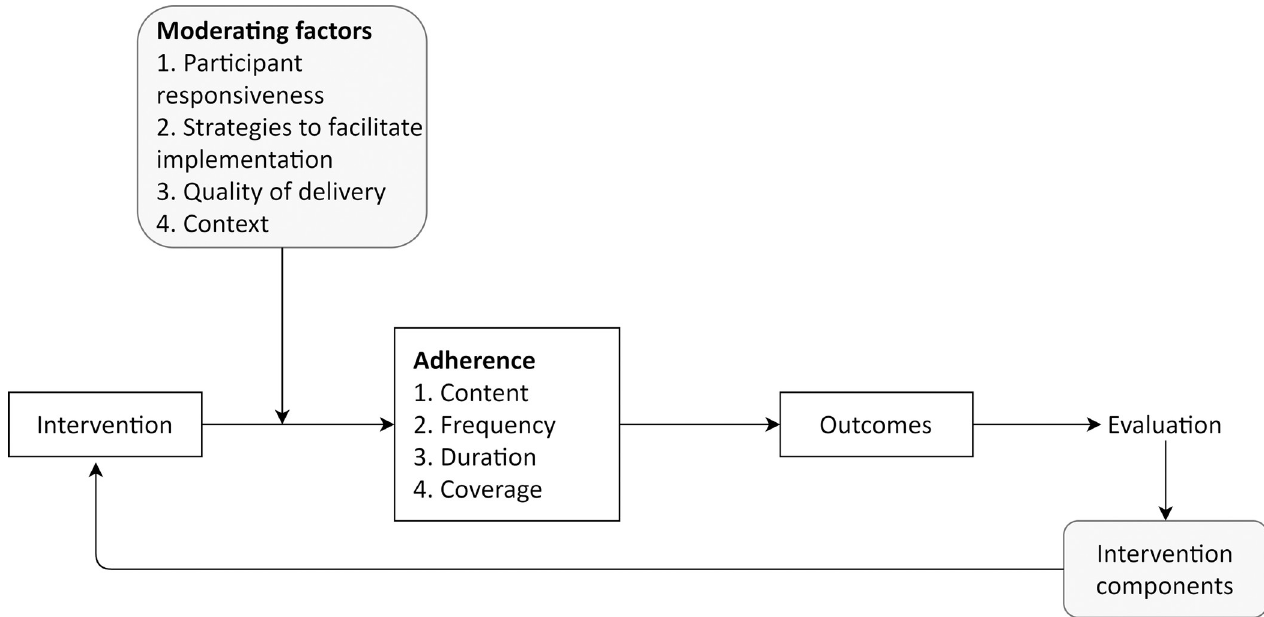
Fig 1. The adapted consolidated framework for intervention fidelity for the ToC intervention.